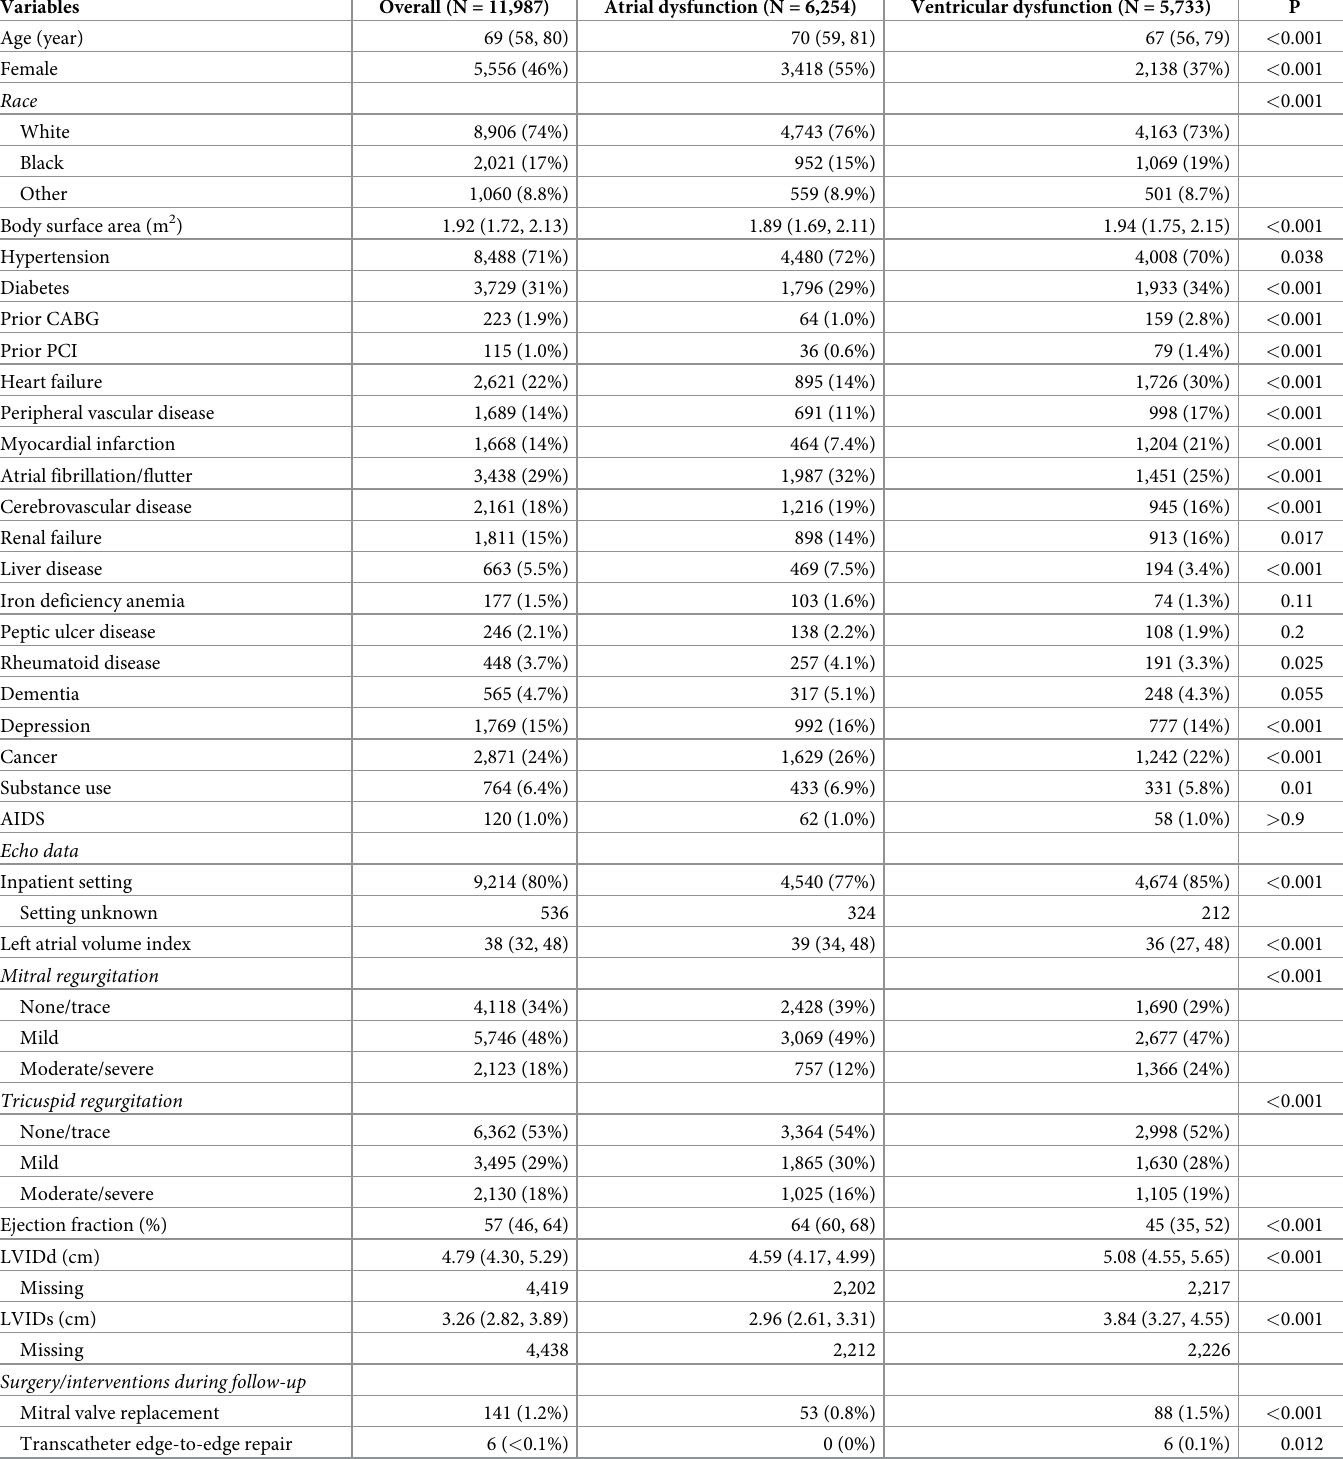
Table 1. Patient characteristics by atrial and ventricular